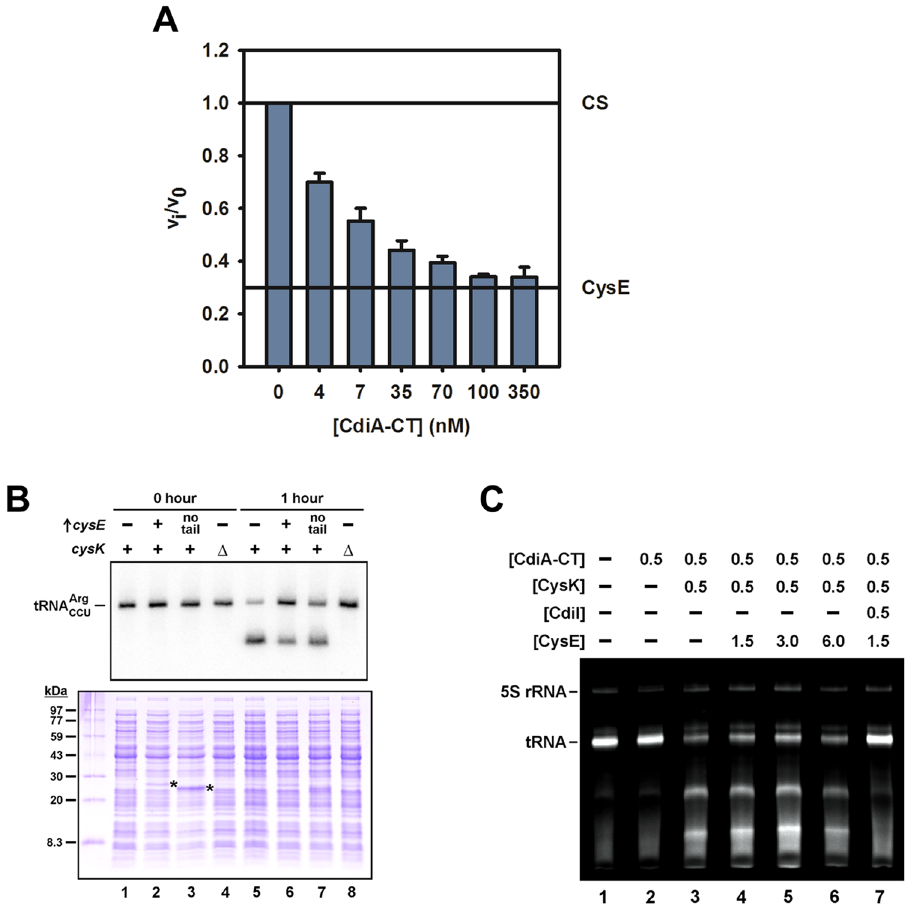
Figure 3. EcCysE and CdiA-CT compete for binding to CysK. ( A ) CdiA-CT blocks formation of the cysteine synthase complex. Increasing concentrations of CdiA-CT were pre-incubated with EcCysK (19 nM) for 20 min prior to the addition of L-Ser (20 mM) and EcCysE (28 nM). Reactions were then initiated by addition of 0.3 mM acetyl-CoA and acetyltransferase activity measured by monitoring the decrease in acetyl-CoA absorption at 232 nm as described in the Methods. The activities of isolated CysE and CysE in the CS complex are shown by horizontal reference lines. ( B ) EcCysE inhibits CdiA-CT toxin activation in vivo . Inhibitor and target cells were co-cultured as described in the Methods. Total RNA and protein were isolated upon initial mixing and after 1 h, and analyzed by Northern blot (top panel) and SDS-PAGE (bottom panel). Where indicated, target cells over-produced EcCysE ( + ) or truncated EcCysE lacking the C-terminal tail (no tail). Target cells carried a deletion of the cysK gene ( ∆ ) where indicated. Asterisks ( * ) in the bottom panel indicate over-produced EcCysE proteins. ( C ) EcCysE inhibits CdiA-CT toxin activation in vitro . EcCysK and EcCysE were pre-incubated at the indicated concentrations ( µ M) prior to addition of CdiA-CT and RNA substrate as described in the Methods. Reactions were quenched after 10 min at 37 °C, then run on 8 M urea-polyacrylamide gels and visualized by ethidium bromide staining. The migration positions of 5 S rRNA and tRNA are